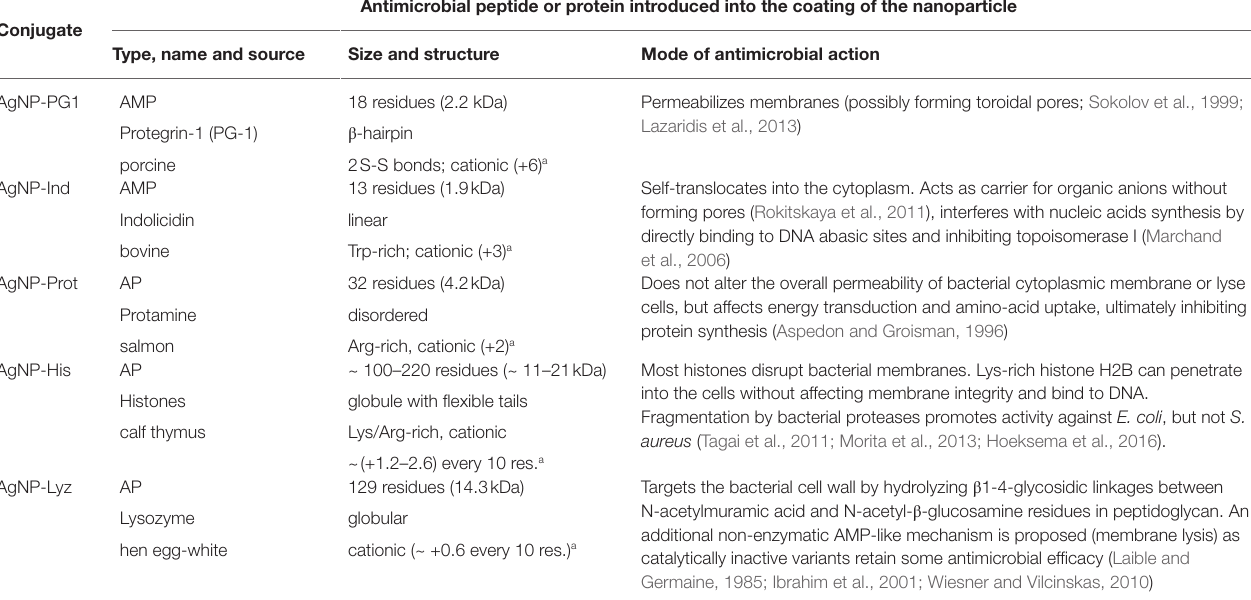
TABLE 1 | Structure and mode of action of antimicrobial peptides and proteins used to create conjugates with silver nanoparticles (AgNPs). Antimicrobial peptide or protein introduced into the coating of the Conjugate